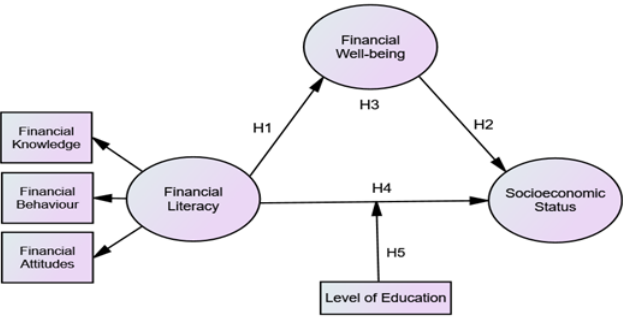
Figure 1. The Proposed Model for The Current Study .